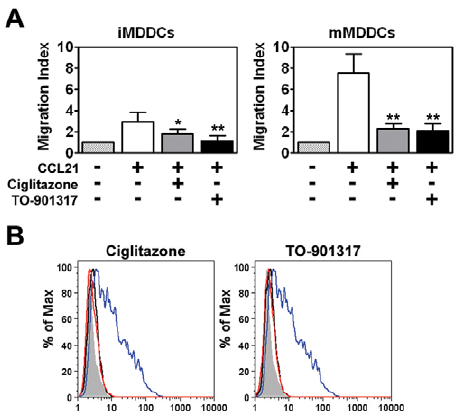
Figure 2. PPAR c and LXR ligand treatment prevents MDDC migration in response to CCL21. (A) Immature (left panel) or mature (right panel) MDDCs were seeded in the upper chamber of a Transwell insert and allowed to migrate in response to medium or a CCL21 gradient in the lower chamber. Migration indexes were determined after four hours. On average, approximately 14% of immature MDDCs (0.34 6 10 5 cells) and 40% of LPS-matured MDDCs (1.08 6 10 5 cells) migrated through the Transwell insert in response to CCL21. (n=3) * p , 0.005, ** p , 0.001 compared to CCL21-treated controls (B) MDDCs were treated with LPS for 48 hours in the presence or absence of 100 m M ciglitazone or 1 m M TO-901317 and analyzed for CCR7 expression by flow cytometry. Shaded histogram, isotype control. Black line, iMDDCs. Blue line, LPS-treated MDDCs. Red line, LPS and nuclear receptor ligand-treated MDDCs.